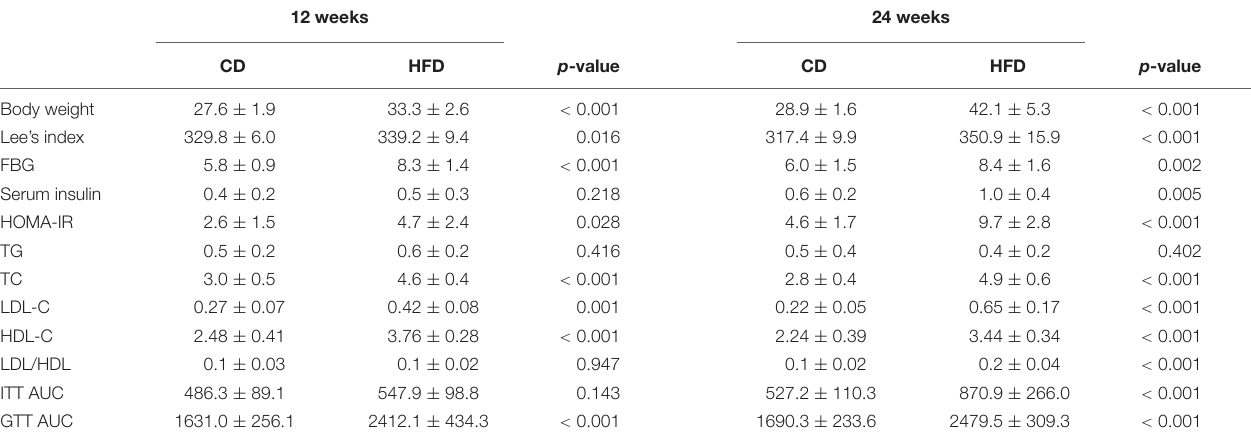
TABLE 1 | The metabolic parameters of mice given chow diet (CD) or high fat diet (HFD) after 12 and 24 weeks, respectively. 12 weeks